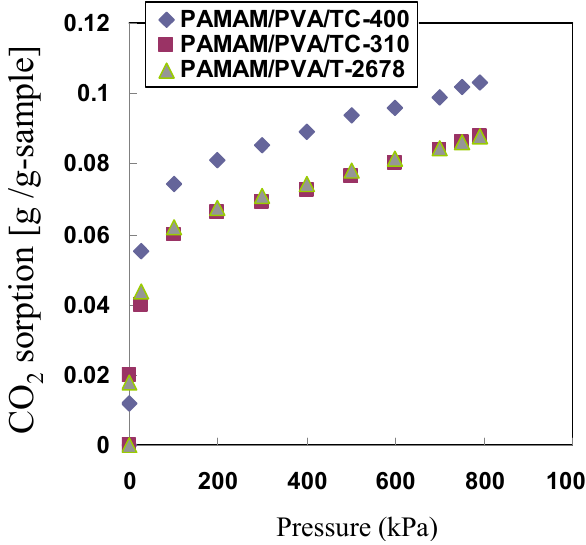
Figure 7. Effect of cross-linker on CO PVA membranes at 40